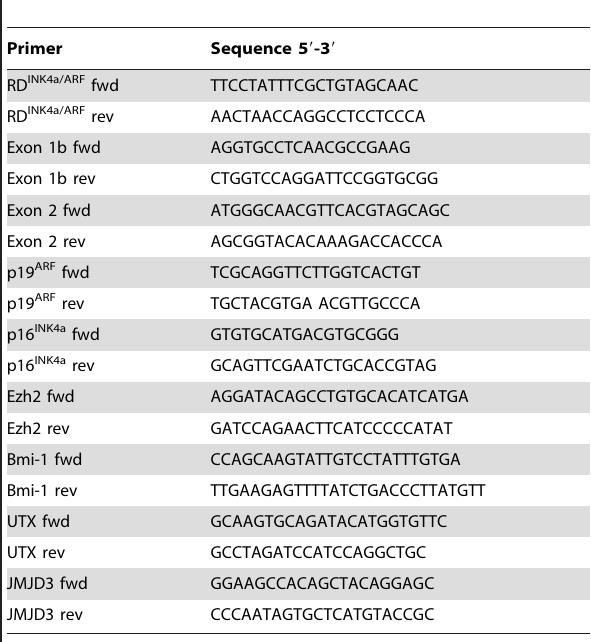
Table 1. Sequences of Primers used for ChIP and gene expression